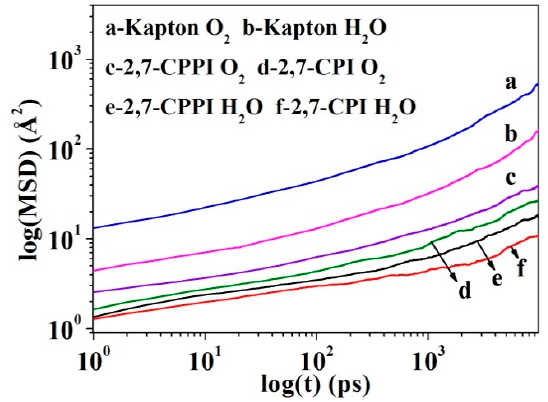
16 of 21 Figure 12. The representative trajectories of O 2 and H 2 O in ( a ) Kapton, ( b ) 2,7 ‐ CPPI and ( c ) 2,7 ‐ CPI. The log(MSD) of O 2 and H 2 O in the three PI systems was plotted as a function of time in Figure 13. The diffusion coefficient was then calculated by the Einstein’s equation in the normal diffusion